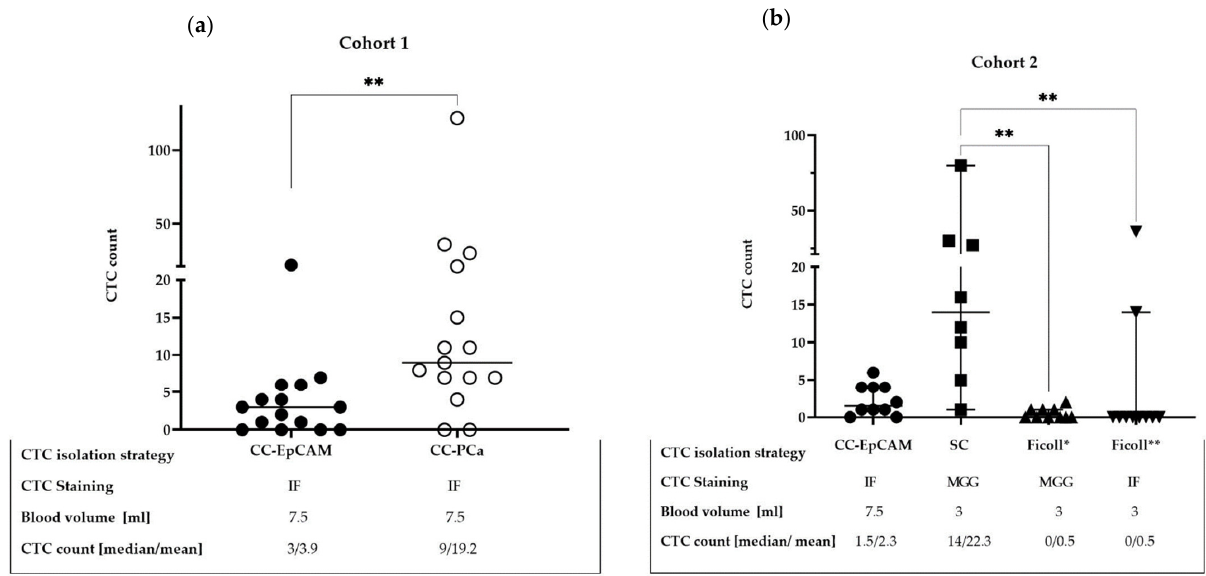
Figure 3. Direct comparison of CTC detection: ( a ) with the CC-EpCAM and CC-PCa systems, and the Wilcoxon matched-pairs signed-rank test was used, p ** 0.002. ( b ) CC-EpCAM, ScreenCell Cyto device (SC) and Ficoll gradient with CD45 depletion Ficoll *-May-Grunwald Giemsa (Ficoll *-MGG) and Ficoll **-immunofluorescence staining (Ficoll **-IF) systems and Dunn’s multiple comparison test were used. Ficoll **-IF vs. SC-MGG, p = ** 0.002 and Ficoll *-MGG vs. SC, p = ** 0.002.